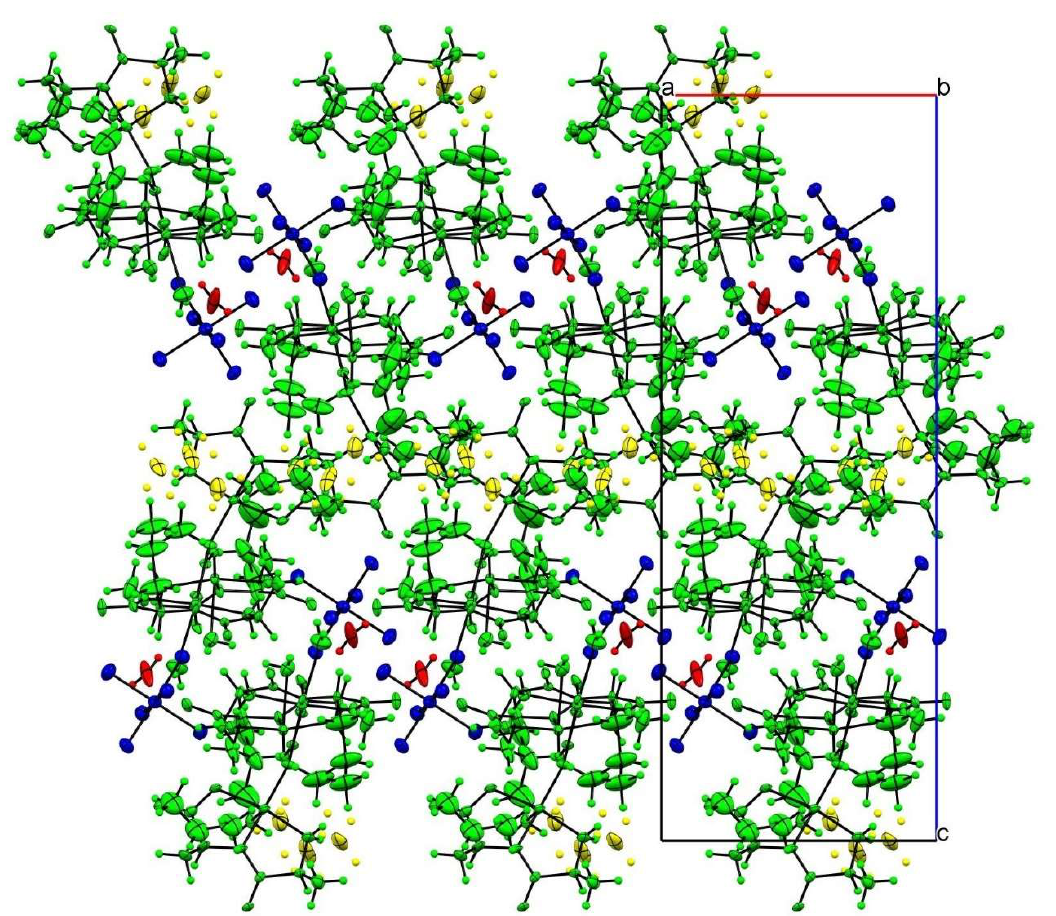
Figure 2. Crystal-structure packing view along the b axis. Color code follows the symmetry equivalence: complex cations (green), disordered alkyl groups (yellow), hexafluorophosphate (blue) and water hydration molecule (red).